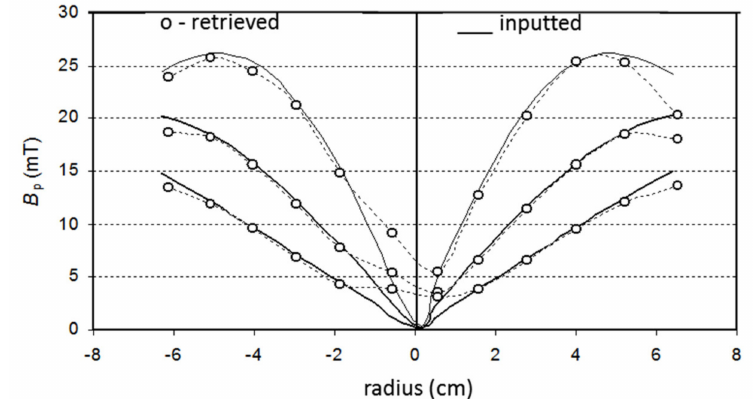
Figure 20. Retrieved poloidal field for three different poloidal field profiles (parabolic, parabolic squared and flat) taking into account beam profile distortion and finite cell size (12 × 5 MCAD with cell width of 4 mm).